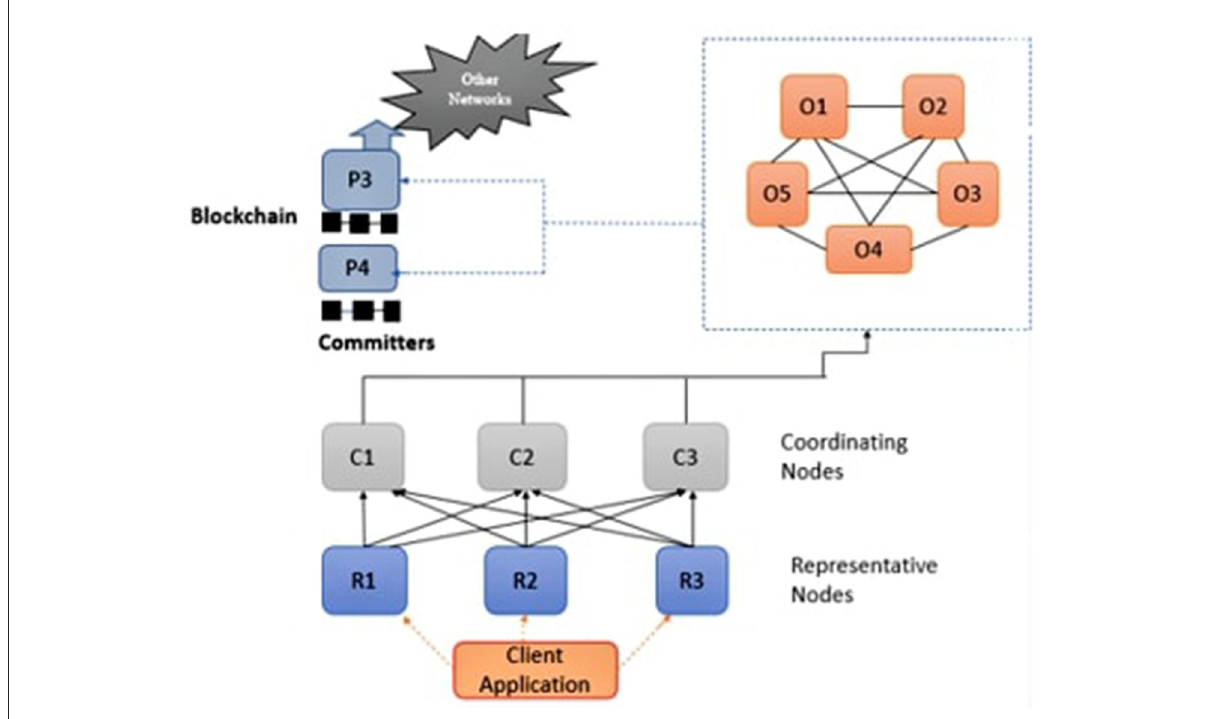
FIGURE4 Blockchain architecture in healthcare